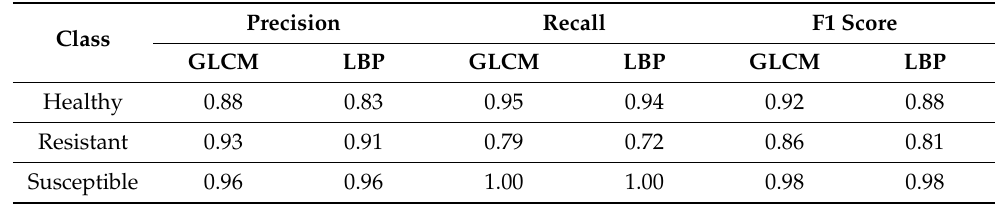
Figure 9. Confusion matrix of XGBoost on GLCM, LBP, and combined texture GLCM-LBP images. Table 6. Performance comparison for CatBoost classification on Grayscale, GLCM, LBP, and combined texture GLCM-LBP